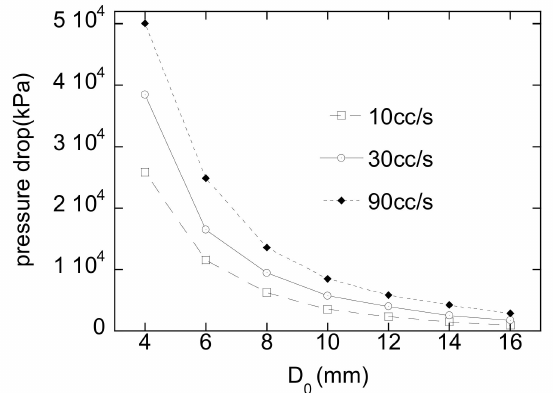
Figure 13. Given a L 1 , pressure drop in a four-nozzle HR along with D 0 for different flow rates (10, 30, and 90